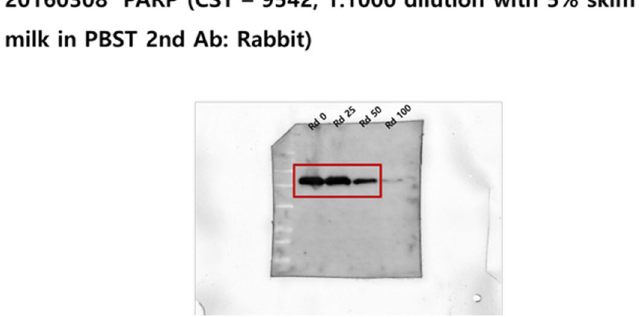
Figure 5. Original image of the membranes showing Radotinib/PARP, corresponding to Fig